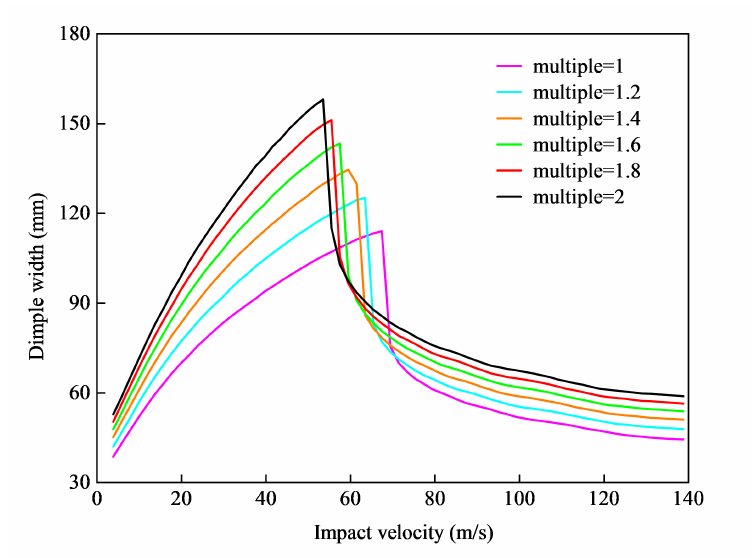
Figure 17. Change in deformation parameters with scaling of the ellipsoidal